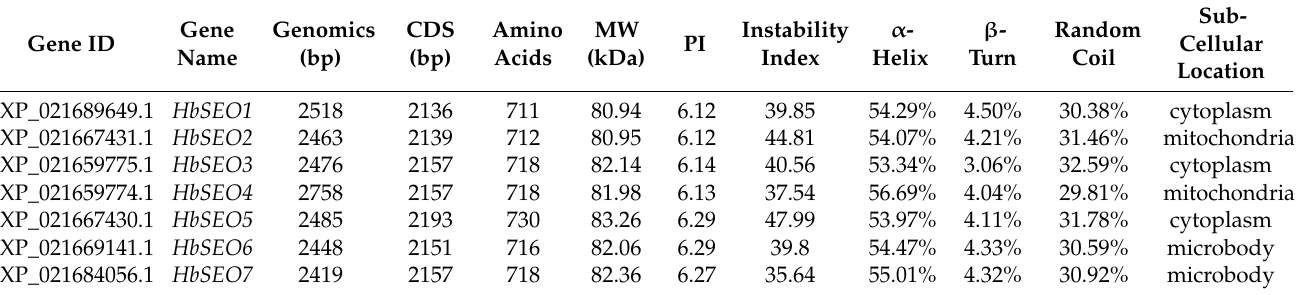
Table 2. Basic protein information of HbSEO genes.